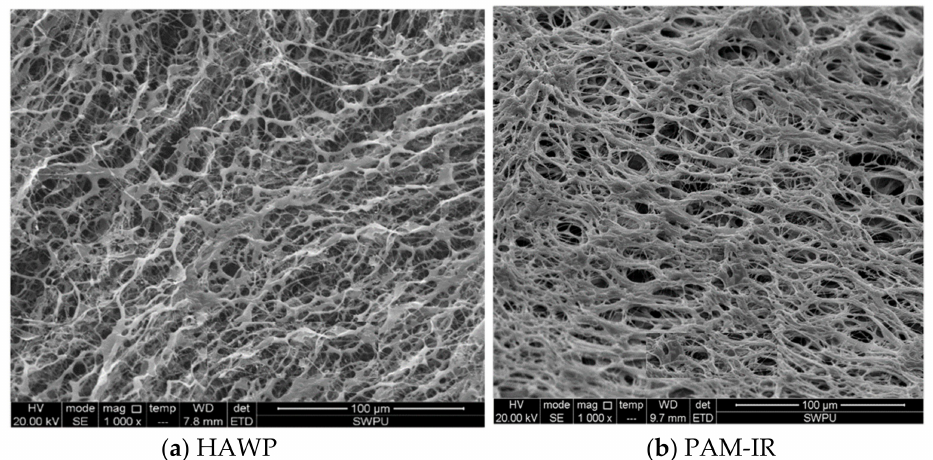
Figure 3. Microstructures of the polymer solutions. ( a ) Microstructure of HAWP; ( b ) Microstructure of PAM-IR.